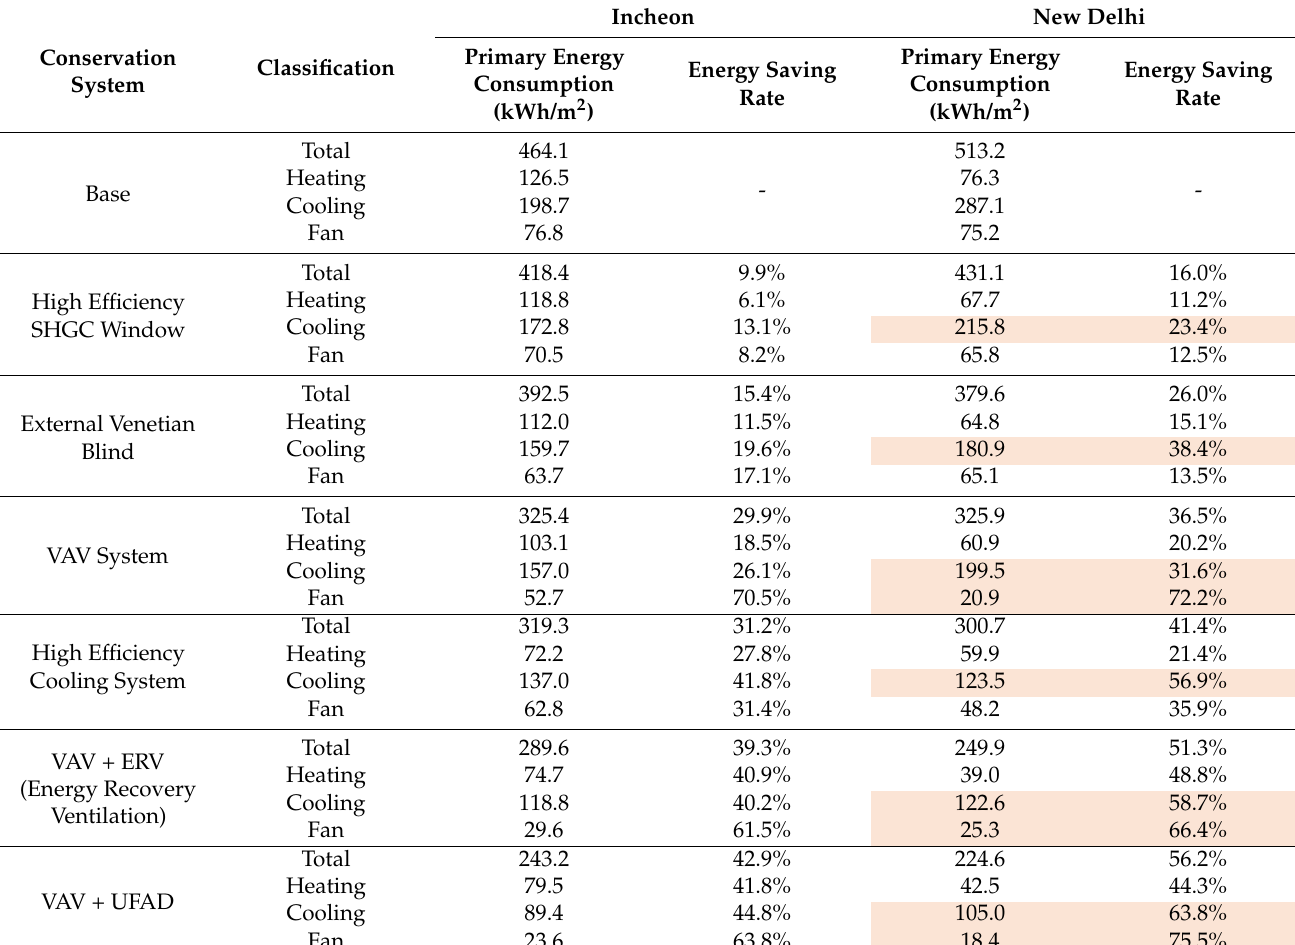
Table 6. Breakdown of the energy consumption and saving rate (comparison of Incheon and New Delhi).